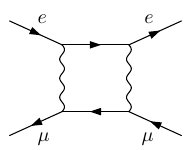
Figure 2. One-loop four-point topology for (cid:22)e scattering.